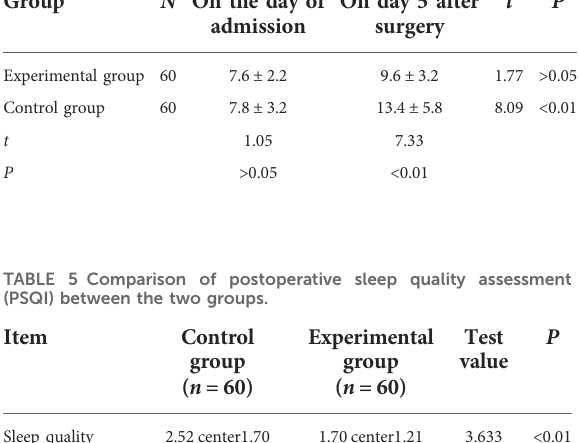
TABLE 4 Comparison of sleep quality assessment (PSQI) in the two groups.